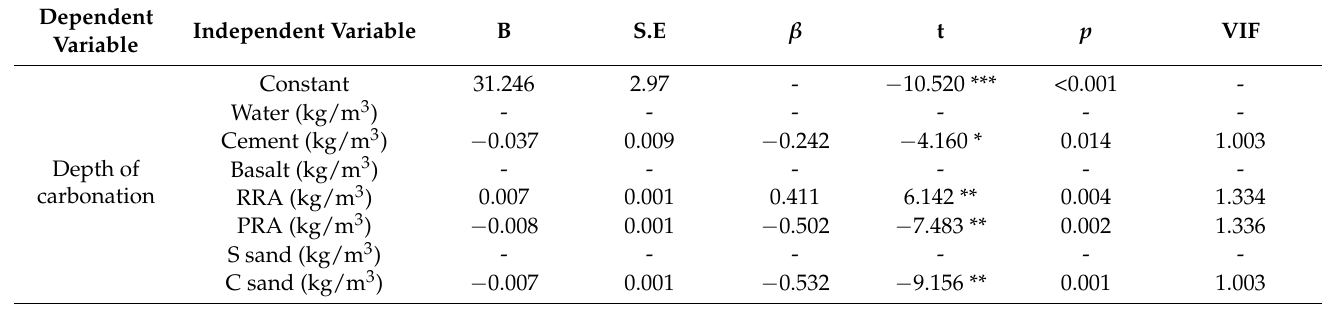
Table 8. Multiple regression analysis for the depth of